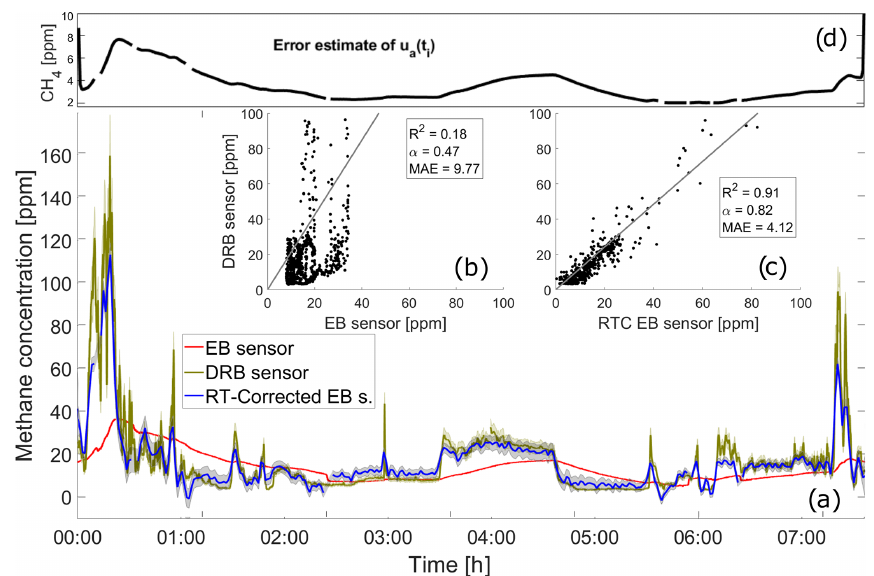
Figure 6. (a) Field data from the DRB (yellow), EB (red), and RT-corrected EB (blue) sensors. Panels (b) and (c) show direct comparison between DRB and the EB sensor data. Coefficient of determination ( R 2 ), mean absolute error (MAE), and slope angle ( α ) are given for comparison between the DRB sensor data and either raw (b) or RT-corrected (c) EB sensor data. Panel (d) shows the error estimate of the RT-corrected signal, u a (t i ) , as 2 standard